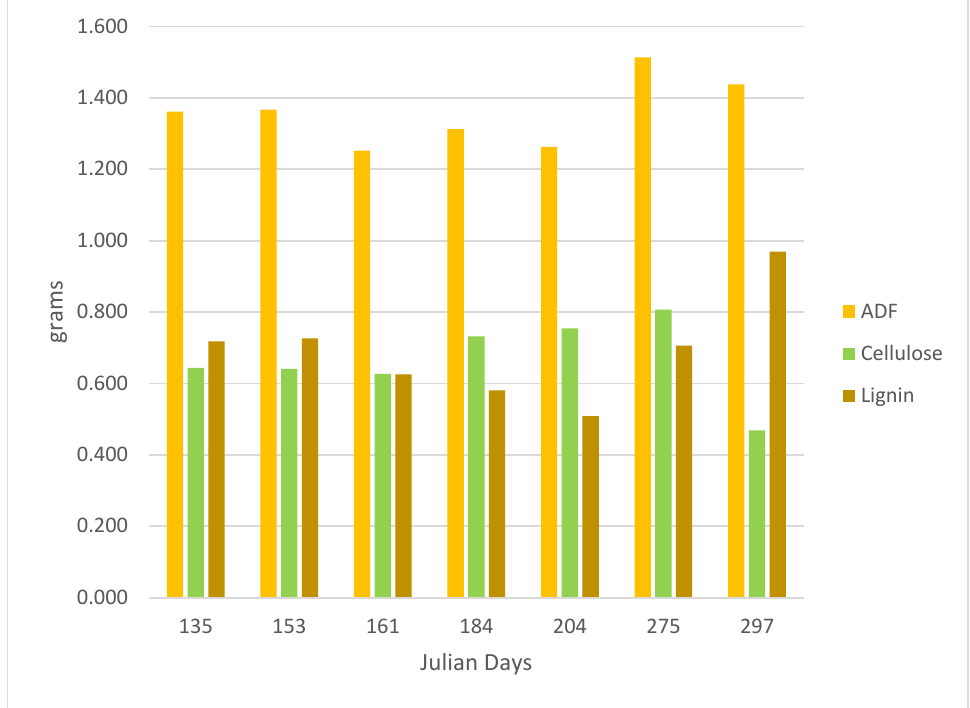
Figure 3. Dynamic of ADF, cellulose, and lignin components expressed as sample-based weights of the remaining biomass for each Julian Day.